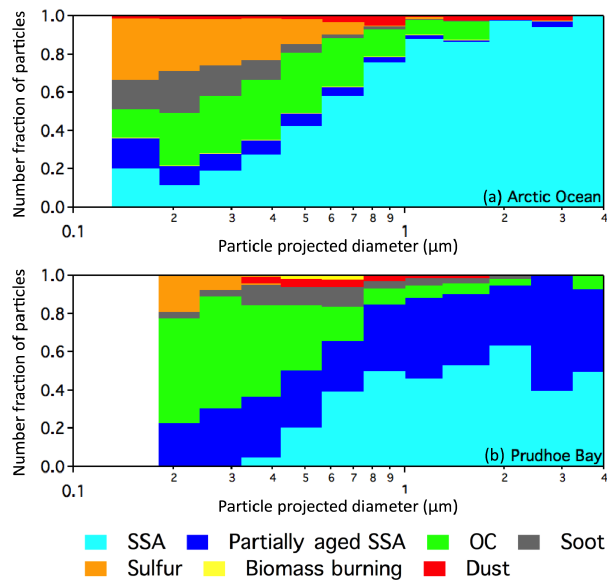
Figure 6. Size and chemical composition of individual particles measured by CCSEM-EDX during influence by (a) the Arctic Ocean (2869 particles analyzed) and (b) Prudhoe Bay (1997 par- ticles analyzed) air masses. For periods influenced by the Arctic Ocean, the following 8h samples were analyzed: 8 September 2015 (00:00–08:00, 08:00–16:00AKDT), 9 September 2015 (00:00– 08:00AKDT), and 15 September 2015 (00:00–08:00AKDT). For periods influenced by Prudhoe Bay, the following 8h samples were analyzed: 23 September 2015 (00:00–08:00, 08:00–16:00AKDT). A histogram of the number of particles analyzed in each bin can be found in the Supplement (Fig.